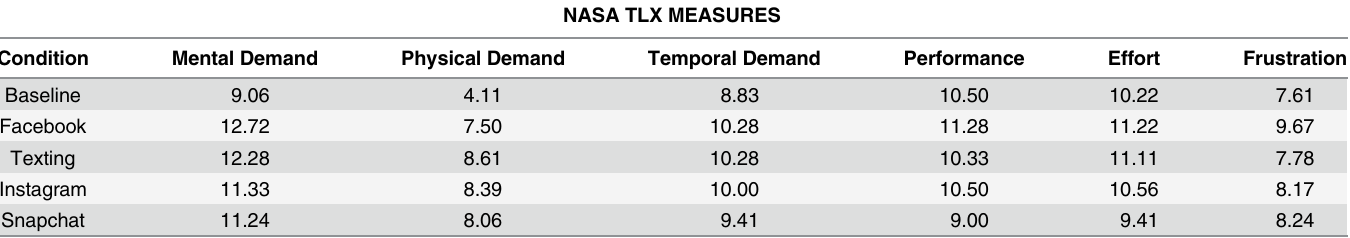
Table 1. Mean task-load response ratings captured from the NASA-TLX form. All responses are based on a 1 – 21 increment scale with 1 being very low and 21 being very